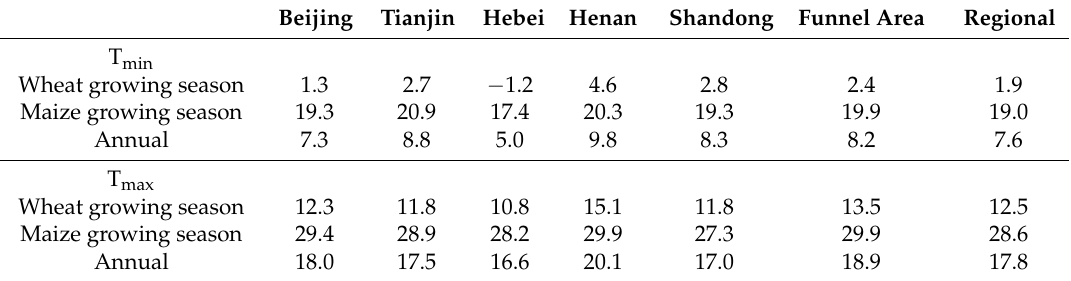
Table 1. The province-wide, funnel area and regional statistics for wheat, maize, and the annual